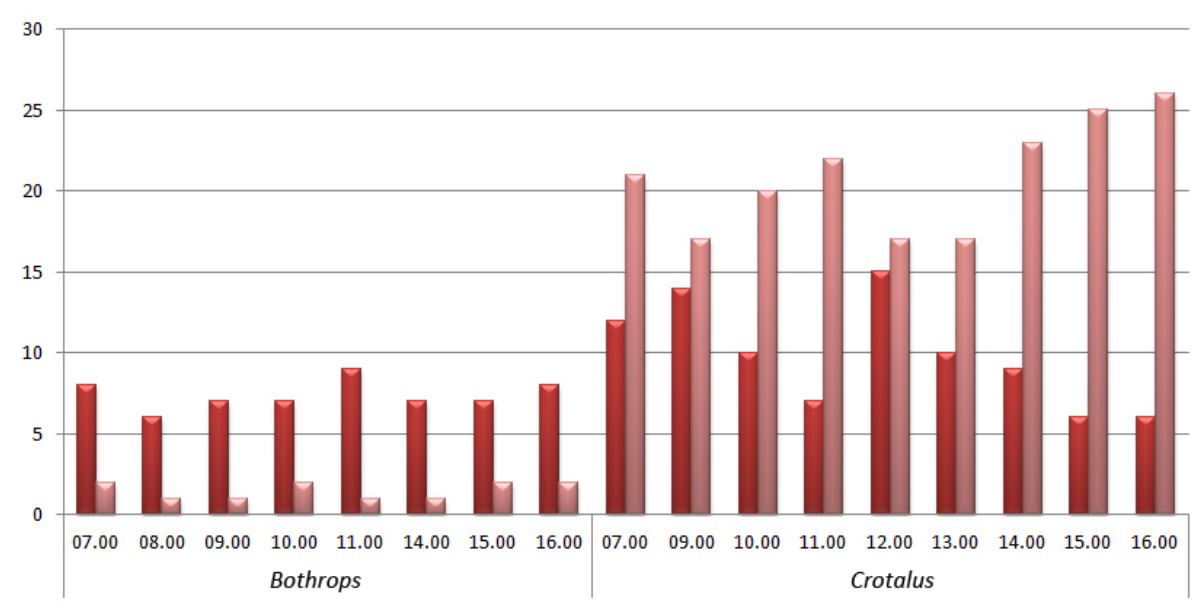
Figure 4. Daily microhabitat distribution of Bothrops and Crotalus